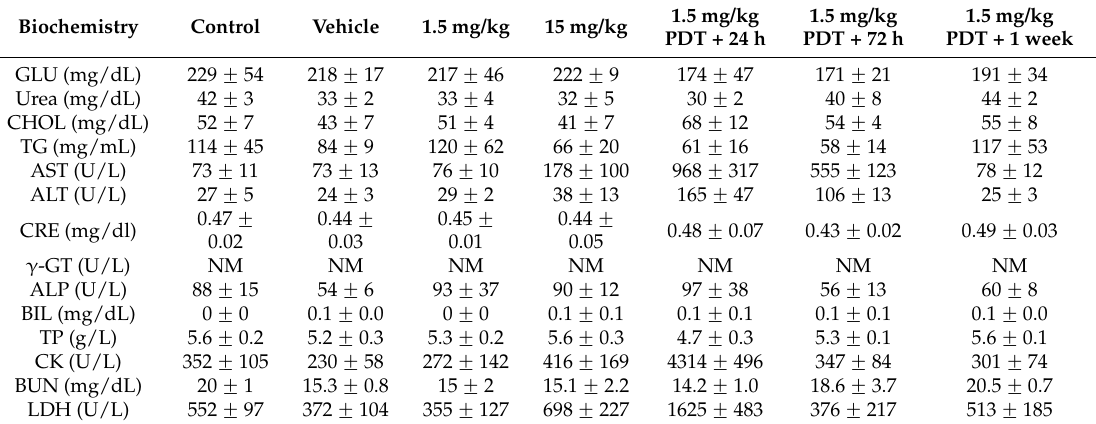
Table A2. Results of the serum biochemistry tests from all study groups, presented as average ˘ SD. Biochemistry